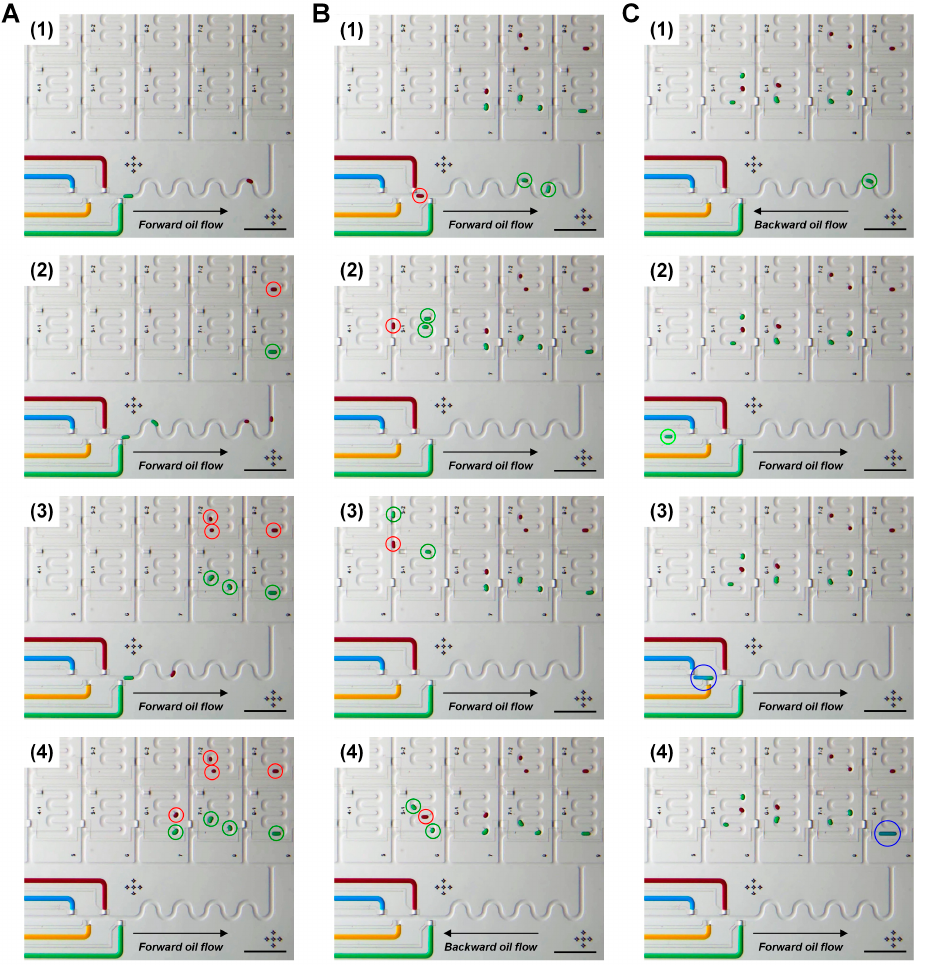
Figure 5. Continuous processes of ( A ) droplet formation and storing, ( B ) repositioning and ( C ) injection and restoring. Scale bars: 1 mm.